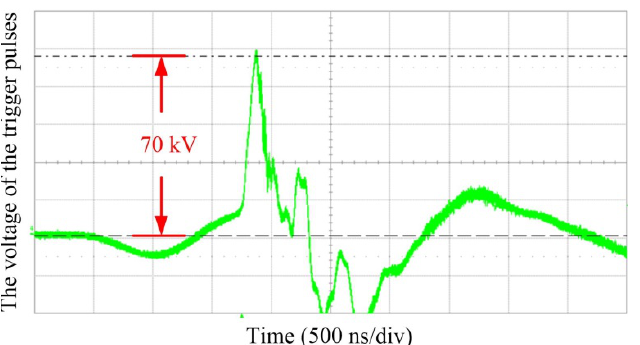
Figure 13. Screen shot of 20 pulses at 30 Hz operation of the trigger source.